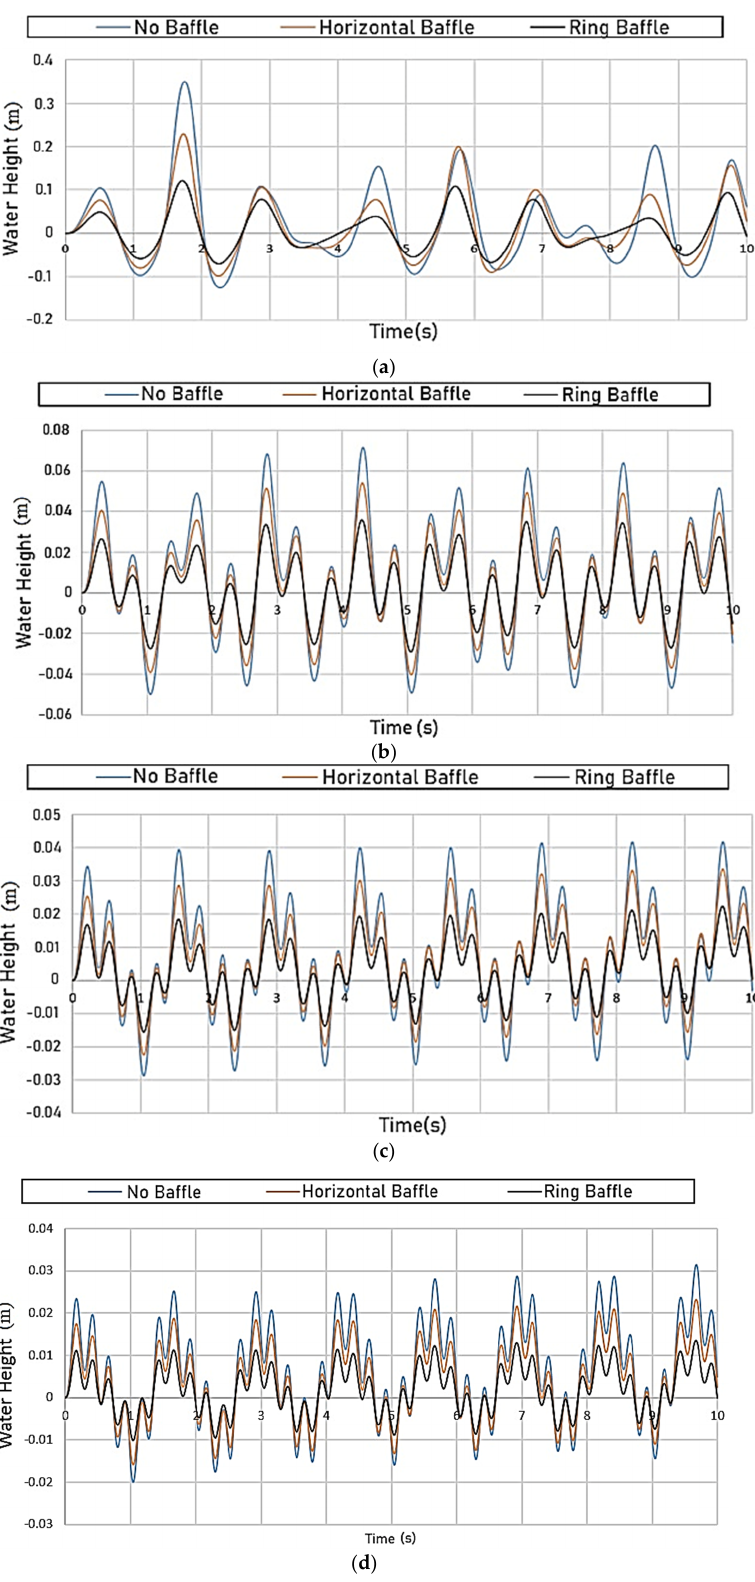
Figure 14. Effect of the baffle on the fluid surface height variations at different frequencies. ( a ) Changes in fluid surface height at the frequency of 1 Hz; ( b ) changes in fluid surface height at the frequency of 2 Hz; ( c ) changes in fluid surface height at the frequency of 3 Hz; ( d ) changes in fluid surface height at the frequency of 4 Hz.